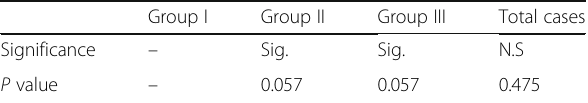
Table 14 Statistical significance for relation between thrombotic severity versus dyslipidemia in the three groups